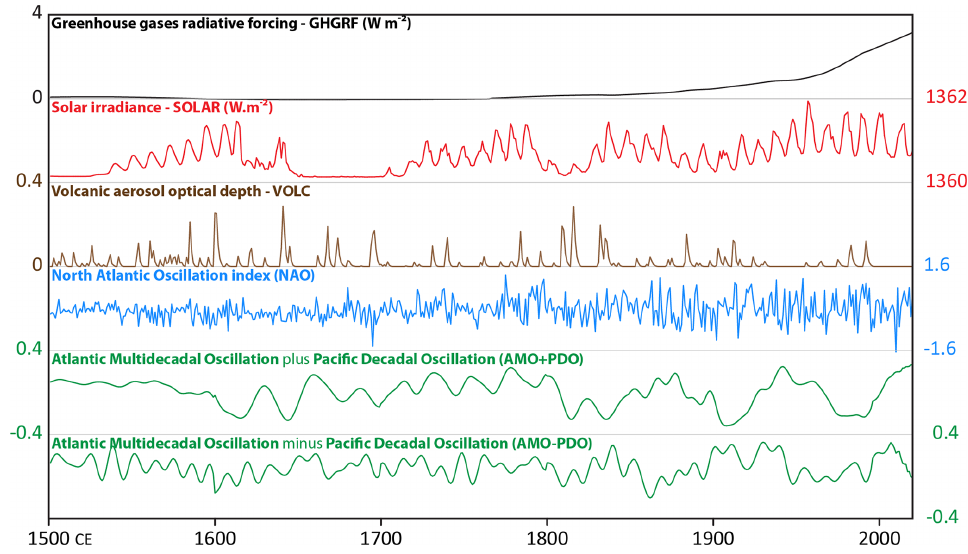
Figure 10. Variability in annual series characterizing external forcings and large-scale internal climate oscillations involved in the attribution